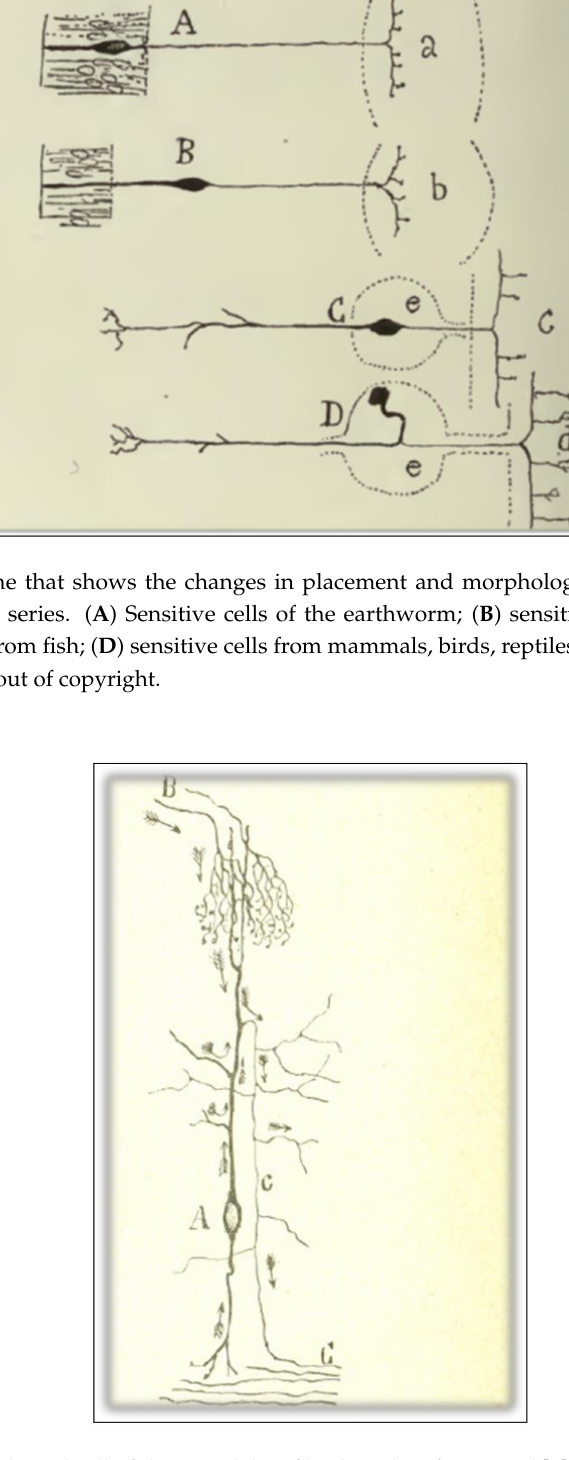
Figure 5. A crook-shaped cell of the optic lobe of birds. Taken from Cajal [6] (p. 3); out of